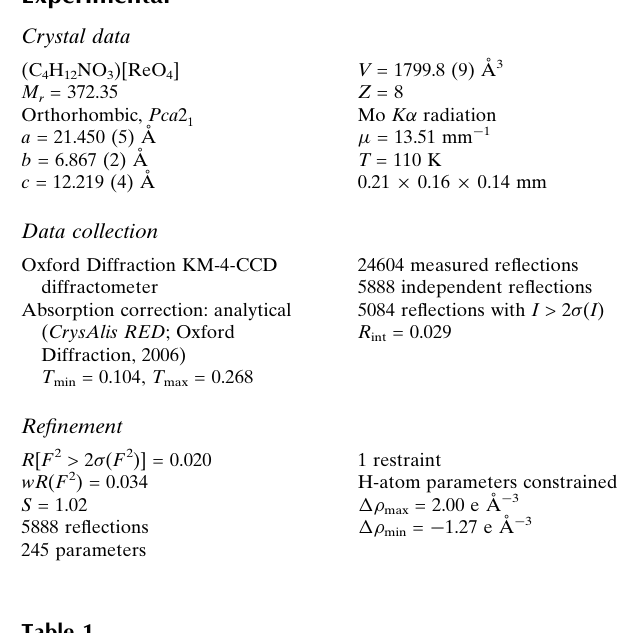
Selected geometric parameters (A˚ , (cid:5) ).